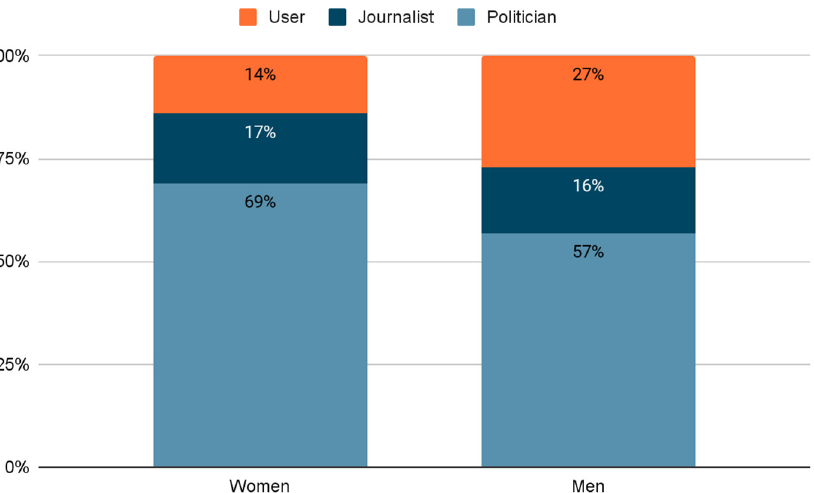
Figure 10. Gender per category of the accounts that the sample of Spanish deputies started to follow in 2017, 2018, 2019 and 2020.